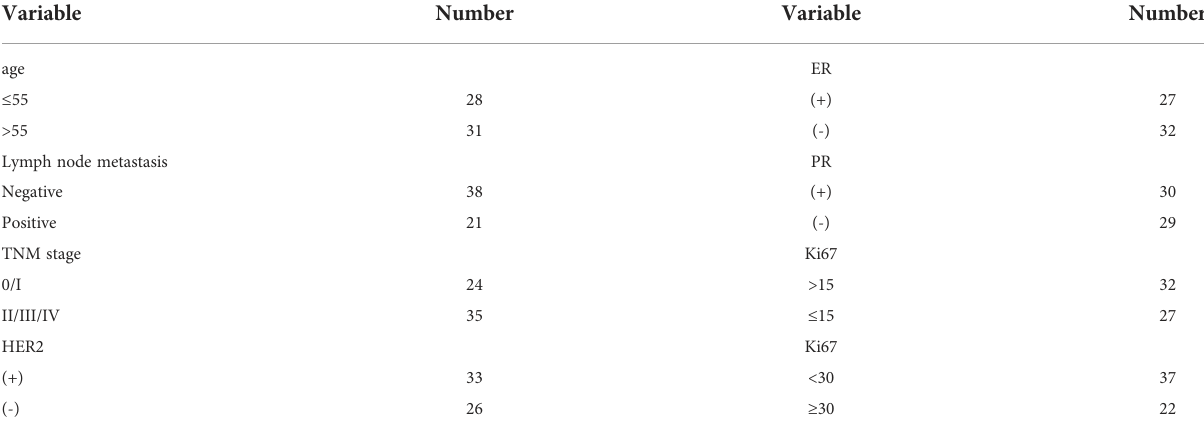
TABLE 5 Pathological grouping of blood